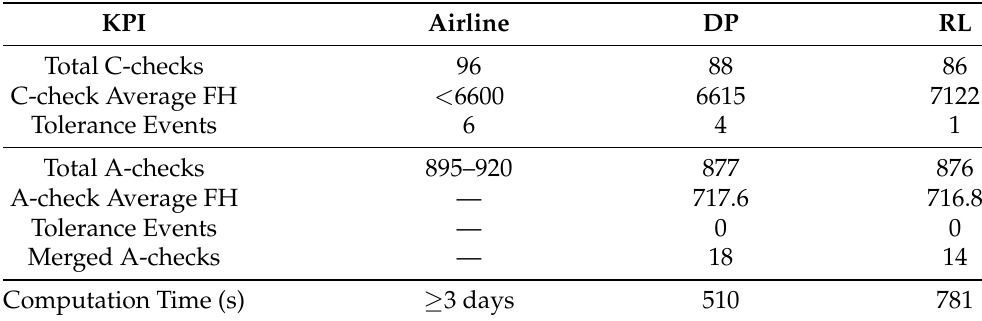
Table 3. Comparison of the A and C-check scheduling results between the three approaches under several Key Performance